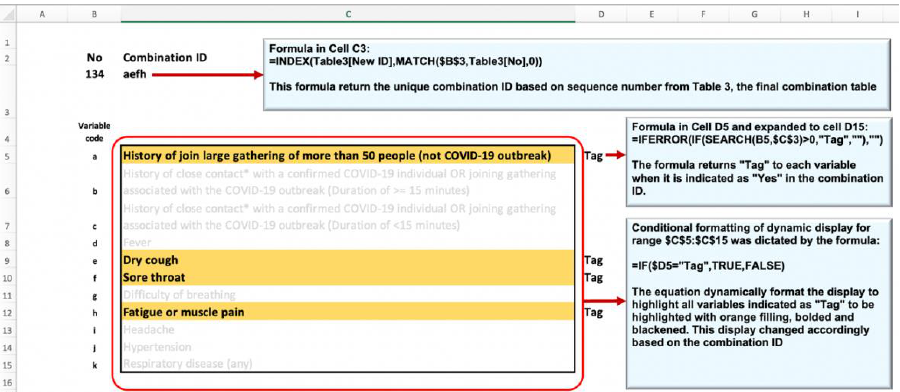
Figure 5. Linking the table of unique combinations with the dynamic display of the rating dash-